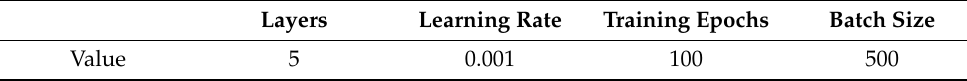
Table 2. Hyperparameter in deep learning model .